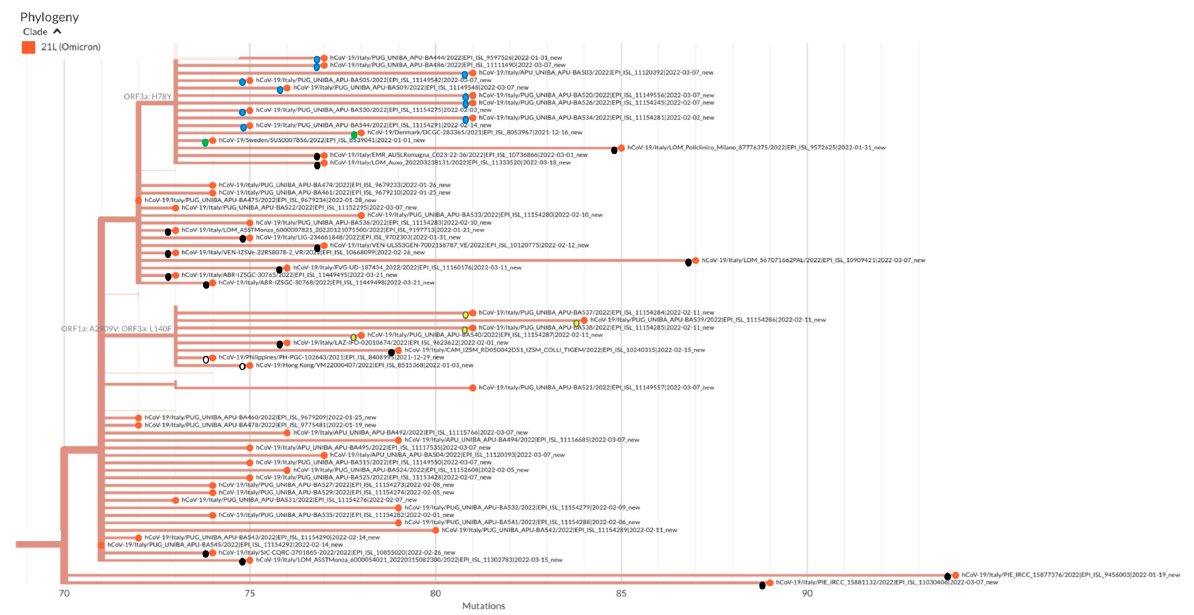
Figure 2. Phylogenetic tree of 60 SARS-CoV-2 Omicron BA.2 sublineage VOC based on their full genome sequences, including the 34 genomes examined in this study. Clade information using the GISAID and Nextstrain nomenclatures is shown. Blue dots indicate the Apulian sequences harboring the H78Y mutation in ORF3a; yellow dots indicate the Apulian sequences harboring the mutations A2909V in ORF1a and L140F in ORF3a; orange dots indicate other Apulian sequences; black dots indicate the Italian sequences included in the analysis; green dots indicate sequences from Denmark/Sweden; and white dots indicate sequences from the Philippines/Hong Kong.